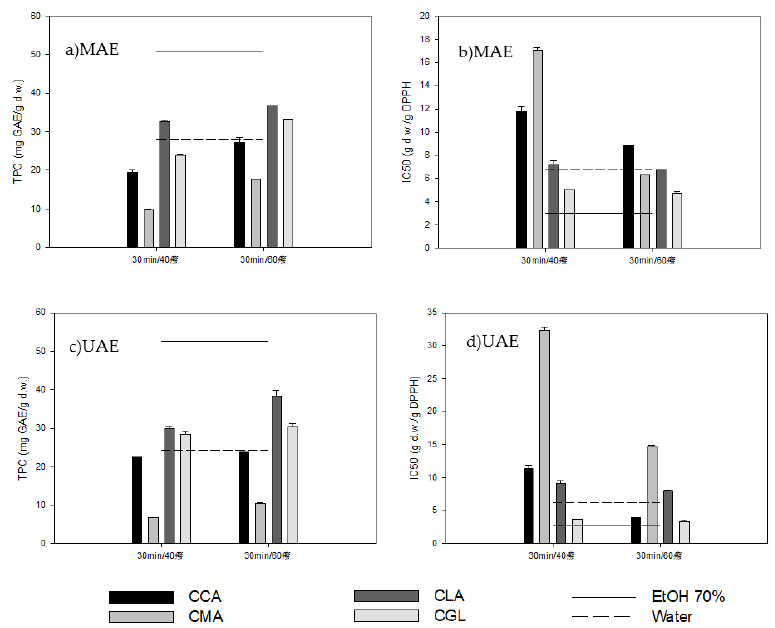
Figure 1. Effect of extraction temperature and NADES type on total phenolic content (TPC) ( a , c ) and antioxidant activity (IC50) ( b , d ) of olive leaf extracts by microwave-assisted extraction (MAE) and ultrasound-assisted extraction (UAE), respectively.